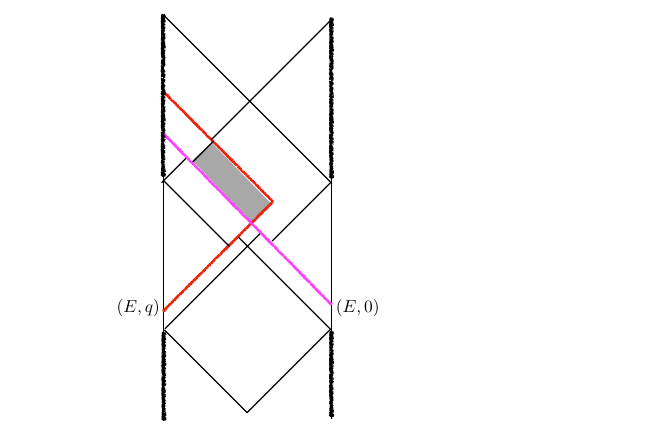
Figure 8 . Collision between a charged particle and a neutral particle carrying the same energy. The post-collision region is